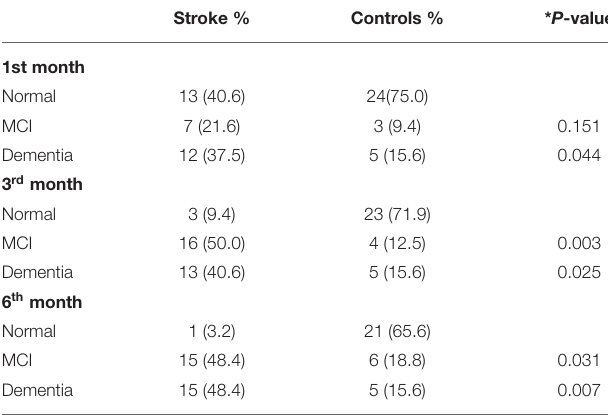
TABLE 1 | Baseline sociodemographic data of the subjects. Cases ( n = 32)